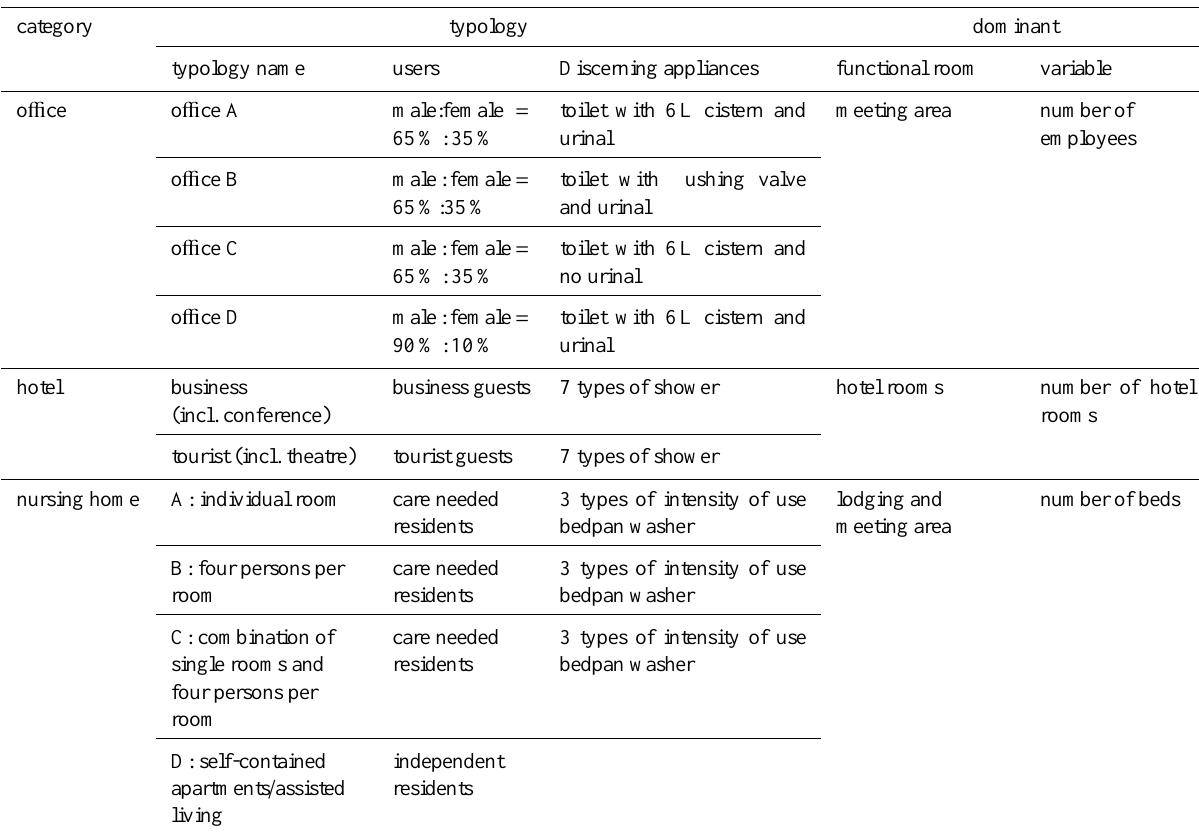
Table 3. Di ff erent typologies of non-residential buildings within the categories o ffi ces, hotels and nursing homes and the dominant functional room and dominant variable in each